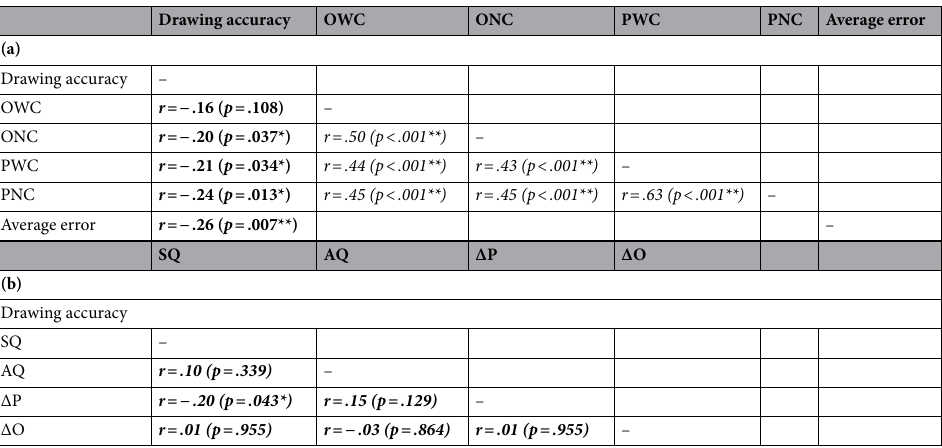
Table 1. (a) Planned correlations among the measures of shape perception (projective judgements with context (PWC), objective judgements with context (OWC), projective judgements without context (PNC), and objective judgements without context (ONC)) (highlighted in italic) and between the measures of shape perception (PWC, OWC, PNC, ONC, and error magnitude collapsed over all shape judgement conditions (Average Error)) and drawing accuracy (highlighted in bold). (b) Planned correlations among the measures of local processing bias (difference scores between projective shape judgement conditions with and without context (ΔP), difference scores between objective shape judgement conditions with and without context (ΔO), AQ, and SQ). In 1a all four shape judgement scores (OWC, ONC, PWC, PNC) are significantly correlated with one another (italic). In addition, all shape judgements (ONC, PWC, PNC, Average Error) except the objective with context (OWC) condition are significantly correlated with Drawing Accuracy (bold). In 1b, the only significant relationship between measures of local processing bias (ΔP, ΔO, AQ, SQ) is between ΔP and SQ scores (bolditalic). N = 125; * p < .05; ** p < .01.